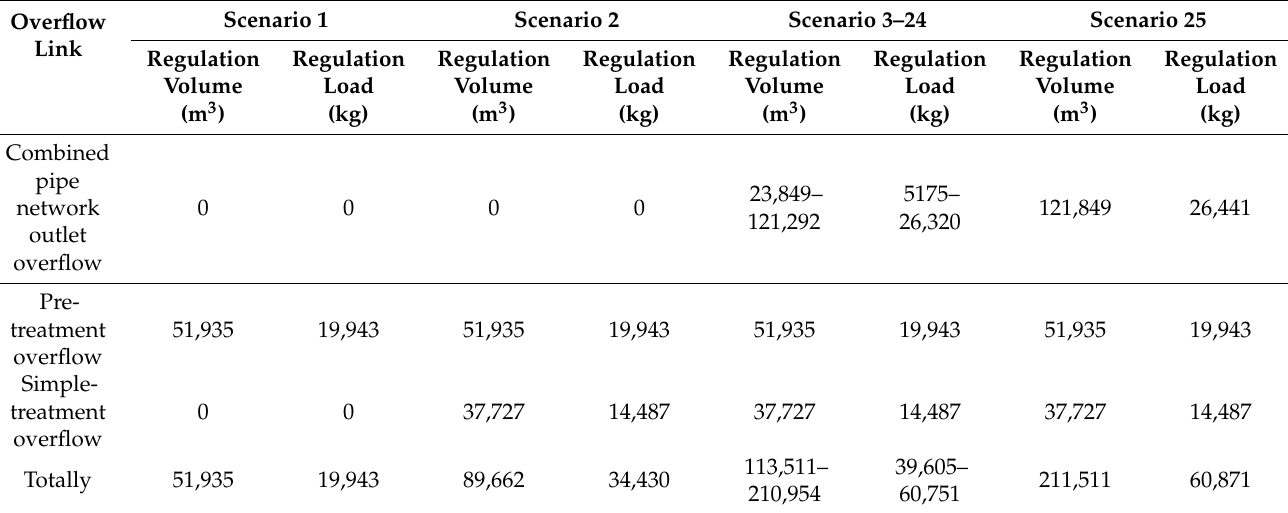
Table 6. Summary of regulation scheme.